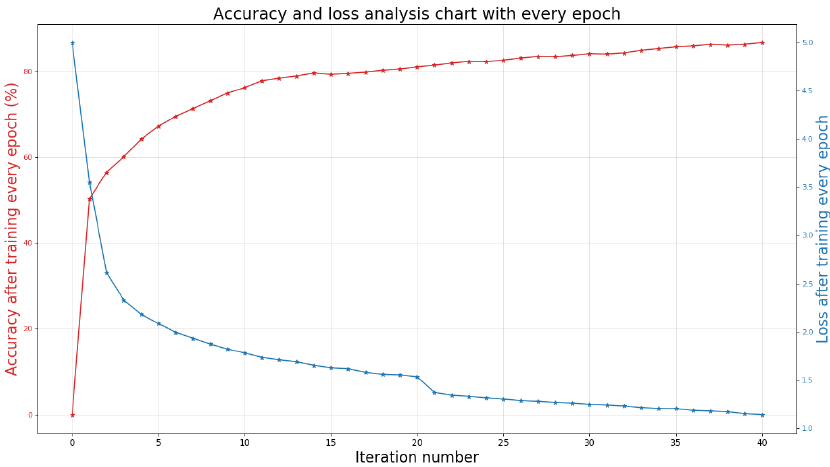
Figure 6. The accuracy and loss value of S3DIS data set with different iteration number